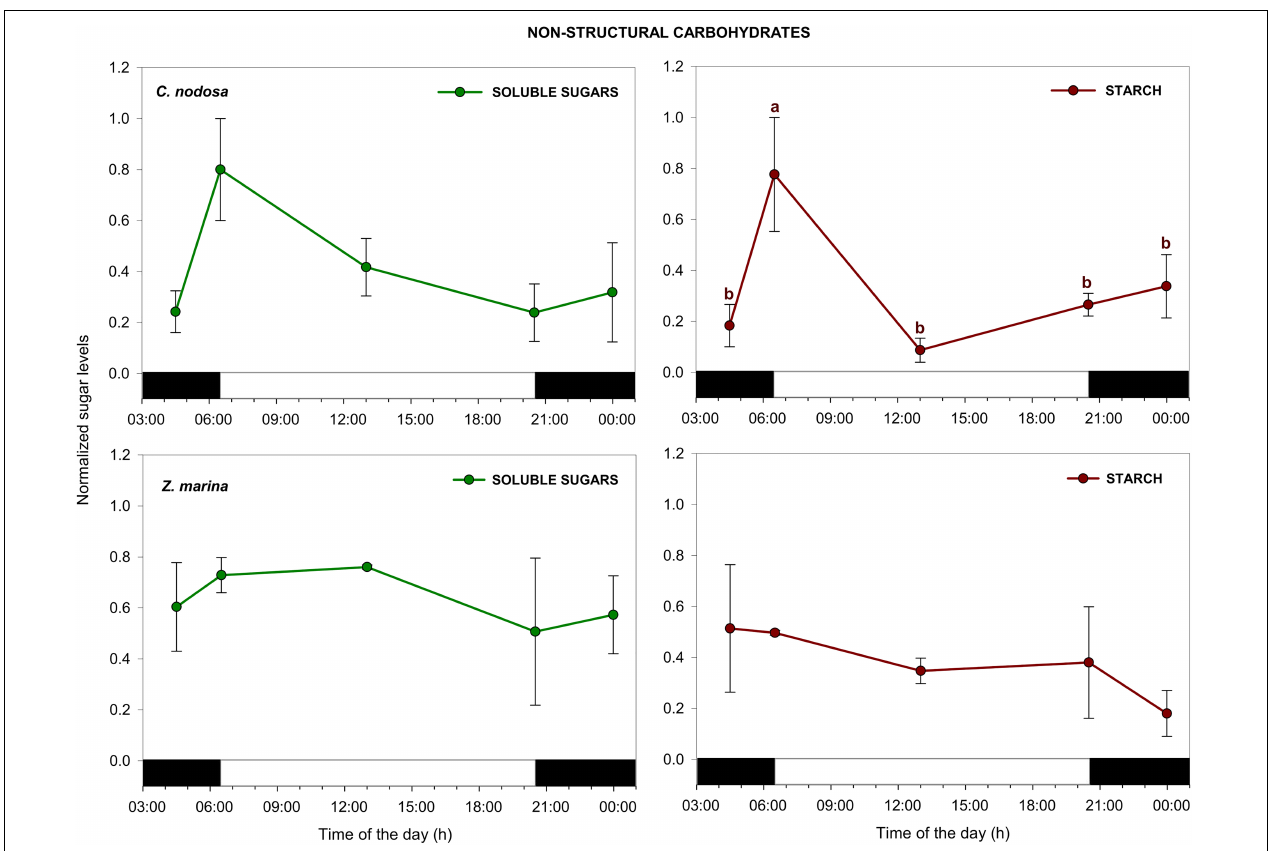
FIGURE 6 | Daily patterns of TNC (soluble sugars and starch) accumulation in C. nodosa and Z. marina . Significant daily changes ( P < 0.05) based on SNK tests following one-way ANOVAs ( Table 5 ), are indicated with different letters. Values are mean ± SE for n = 3.